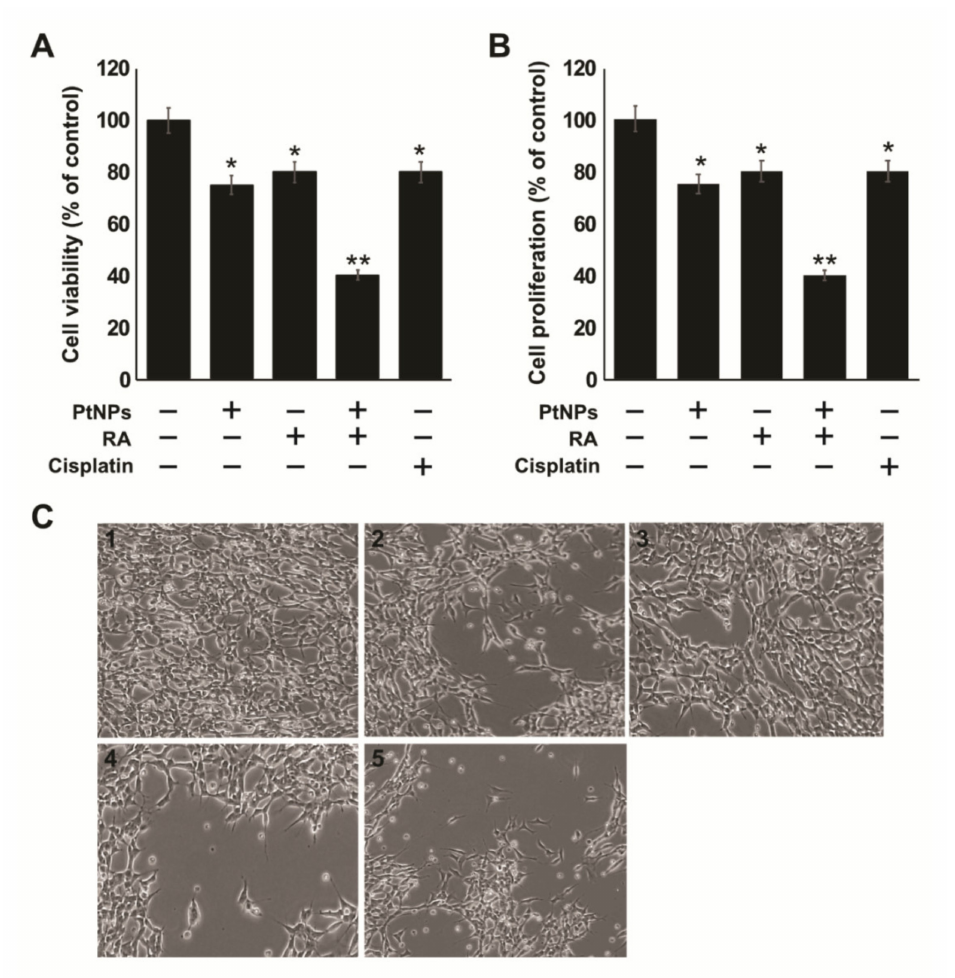
Figure 4. Combination of PtNPs and RA induces loss of cell viability, reduces proliferation, and alters cell morphology in SH-SY5Y cells. SH-SY5Y cells were incubated with PtNPs (25 µ g / mL), RA (12.5 µ M), combination of PtNPs (25 µ g / mL) and RA (12.5 µ M), or cisplatin (6.5 µ M) for 24 h. Cell viability ( A ), cell proliferation ( B ), were determined. The results are expressed as mean ± standard deviation of three independent experiments. The treated groups showed statistically significant di ff erences from the control group per the Student’s t -test; * p < 0.05 was considered significant, ** p < 0.01 was considered highly significant. PtNPs, platinum nanoparticles; RA, retinoic acid. Cell morphology control (1), PtNPs (2), RA (3), combination of PtNPs and RA (4), or cisplatin (5) for 24 h ( C ). Scale bar-200 µ